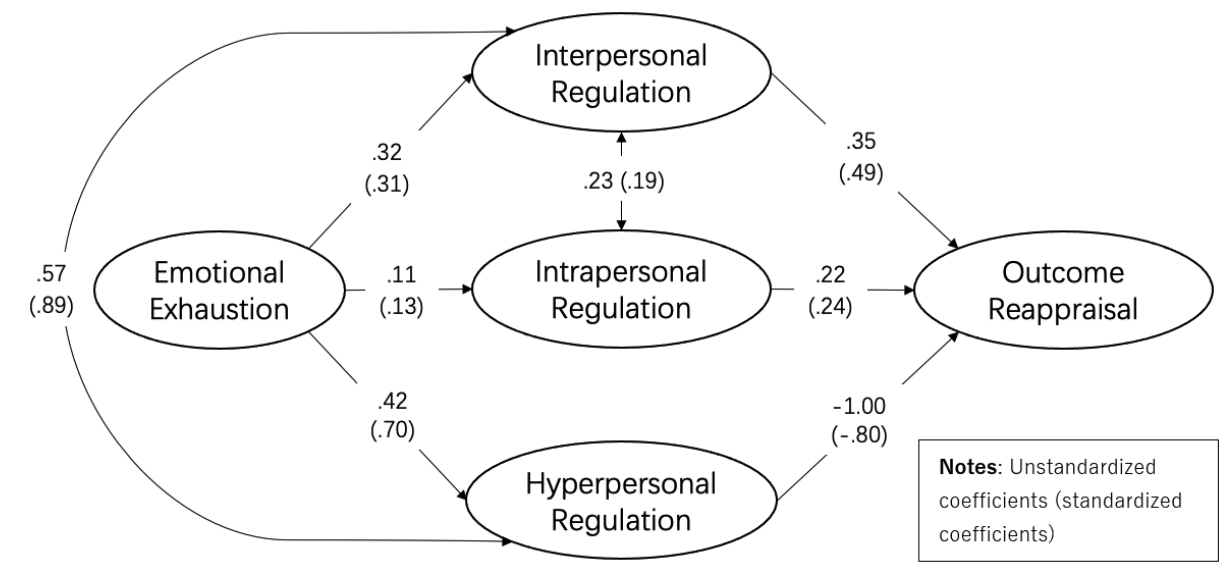
Figure 2. Revised